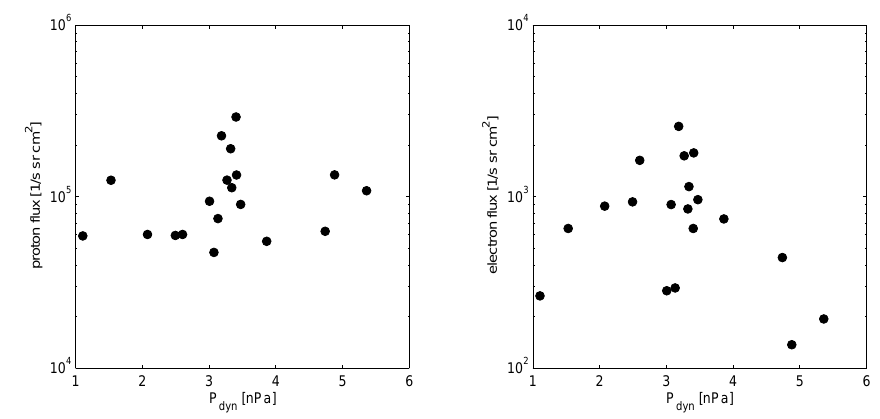
Fig. 6. Total energetic particle fluxes in the exterior cusp as a function of solar wind dynamic pressure. Proton fluxes are shown in the left and electron fluxes in the right.